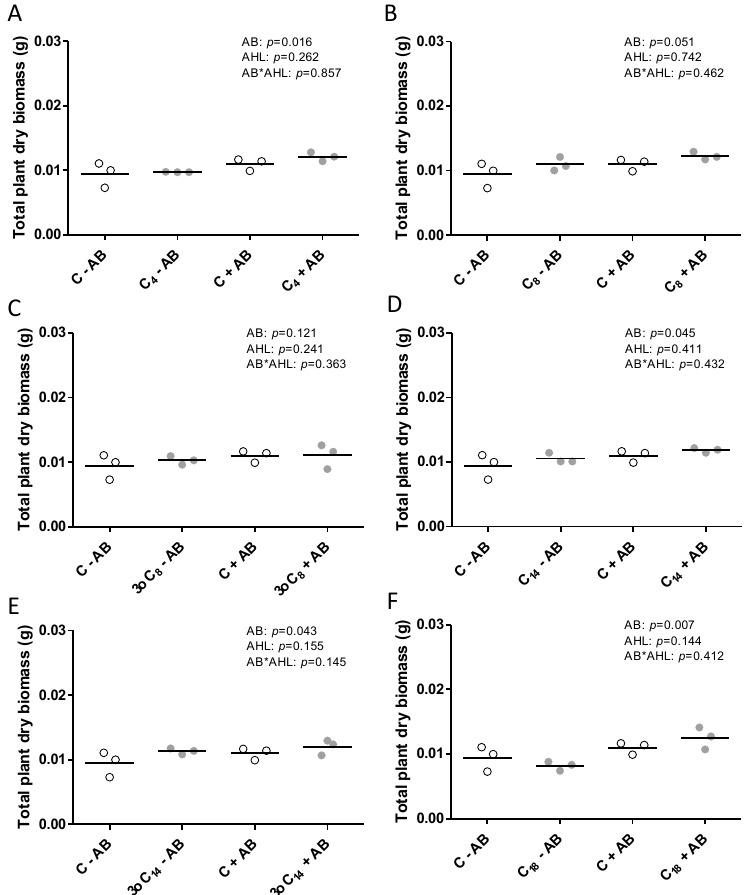
Figure 5. Total dry biomass (root and shoot biomass) (g plant − 1 ) in M. truncatula plants exposed to 1 µ M AHLs and inoculated with rhizobia, measured at 21 days after inoculation. Plants were treated with (grey) or without (white) ( A ) C 4 -HSL, ( B ) C 8 -HSL, ( C ) 3-oxo-C 8 -HSL, ( D ) C 14 -HSL, ( E ) 3-oxo-C 14 -HSL, or ( F ) C 18 -HSL. The control treatments (‘C’) included the same dilution of the solvent as the AHL treatments. Di ff erent letters indicate significant di ff erences between the treatments when the interaction is significant (REML test p < 0.05). No post hoc test when the interaction is not significant. AB: antibiotic treatment. Each one of the three data points represents a measurement of 10 roots combined, because individual roots were too light to weigh accurately.